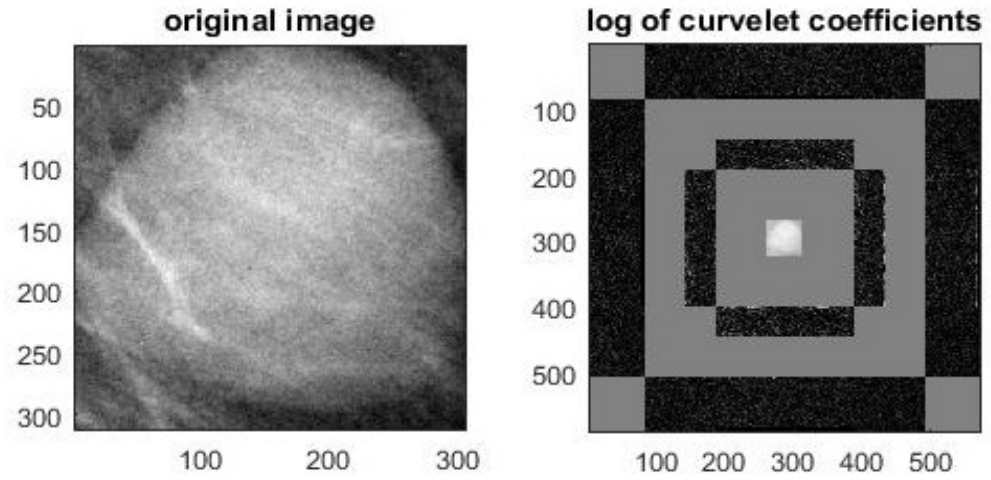
Figure 2. The curvelet transform of the mass region of interest (ROI). ( Left ) Original ROI image, ( Right ) the different wedges representation.